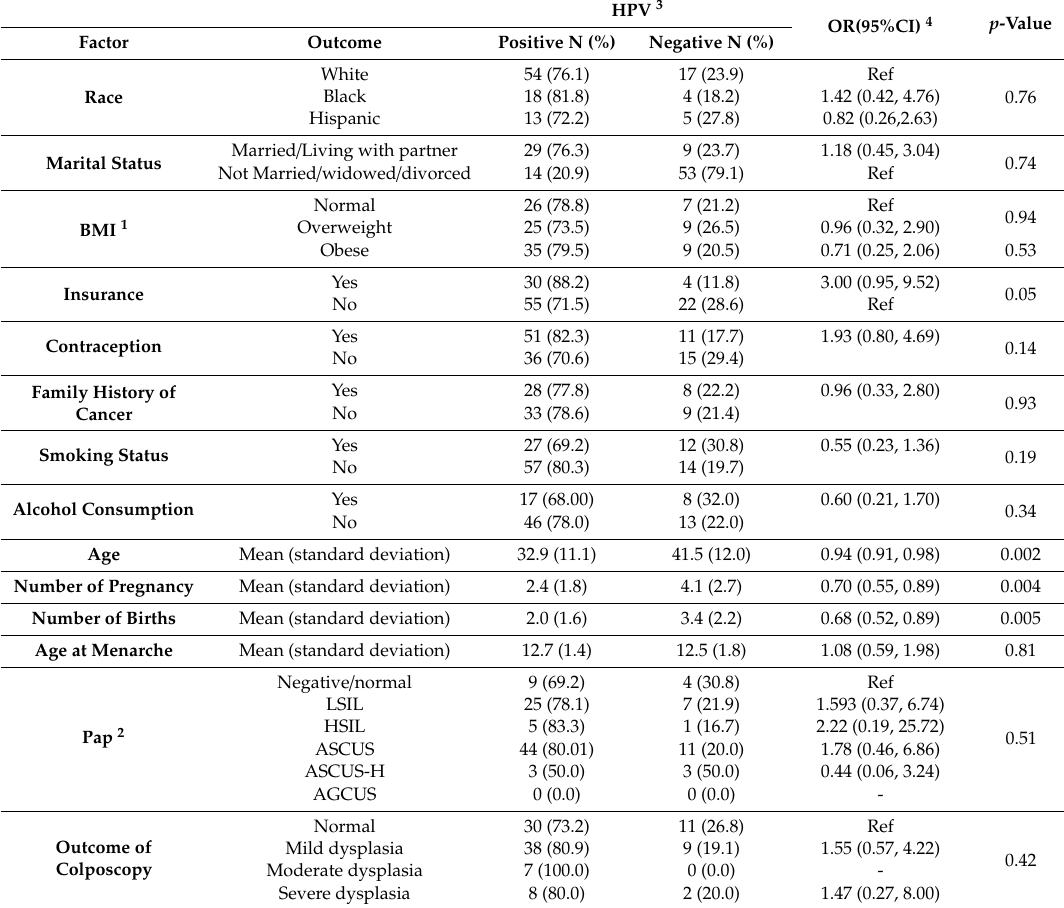
1 BMI: Body mass index was determined following National Heart Lung and Blood Institution criteria: Underweight = <18.5; Normal weight = 18.5–24.9; Overweight = 25–29.9; Obese = BMI of 30 or greater